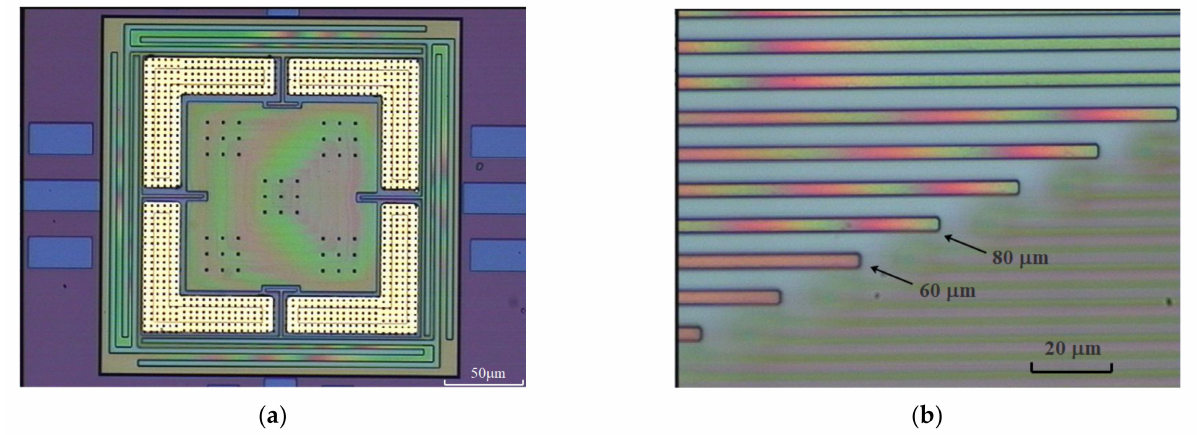
Figure 7. Optical images of released structures; ( a ) diaphragm supported by four beams; ( b ) cantilever array. Cantilevers longer than 80 µ m are colorful due to the interference patterns of uneven gaps, while those shorter than 60 µ m exhibit uniform color, which indicates that all cantilevers longer than 80 µ m adhered to the substrate. Stiction strength is estimated using the longest unstuck cantilever and shortest stuck cantilever.